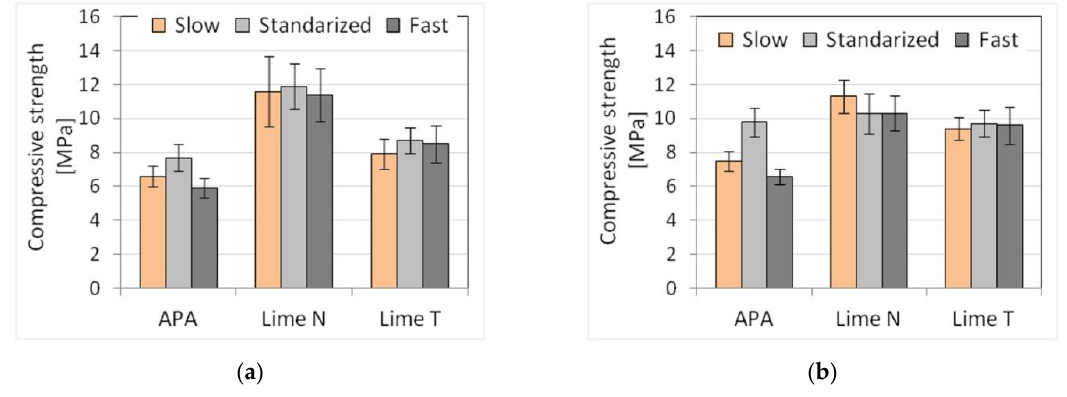
Figure 14 . Influence of the mixing intensity on the compressive strength of ( a ) plaster, ( b ) masonry mortars.